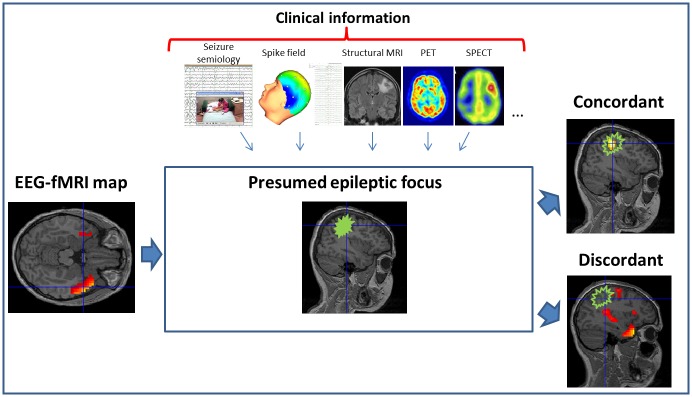
Clinical assessment of the EEG-fMRI maps.EEG-fMRI maps are compared with the location of the presumed epileptogenic region (green area). Epileptogenic region is assessed clinically based on multimodal tests. Maps are classified as Concordant if a cluster of significant activation is present in the epileptogenic region and Discordant otherwise.